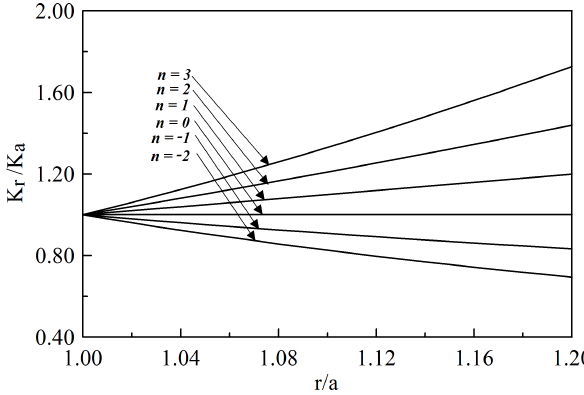
Figure 5: Radially distributed thermal conduction